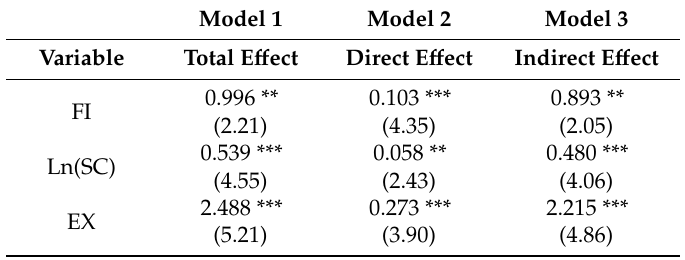
Table 5. The direct and indirect e ff ects of the spatial Durbin model at the provincial level.